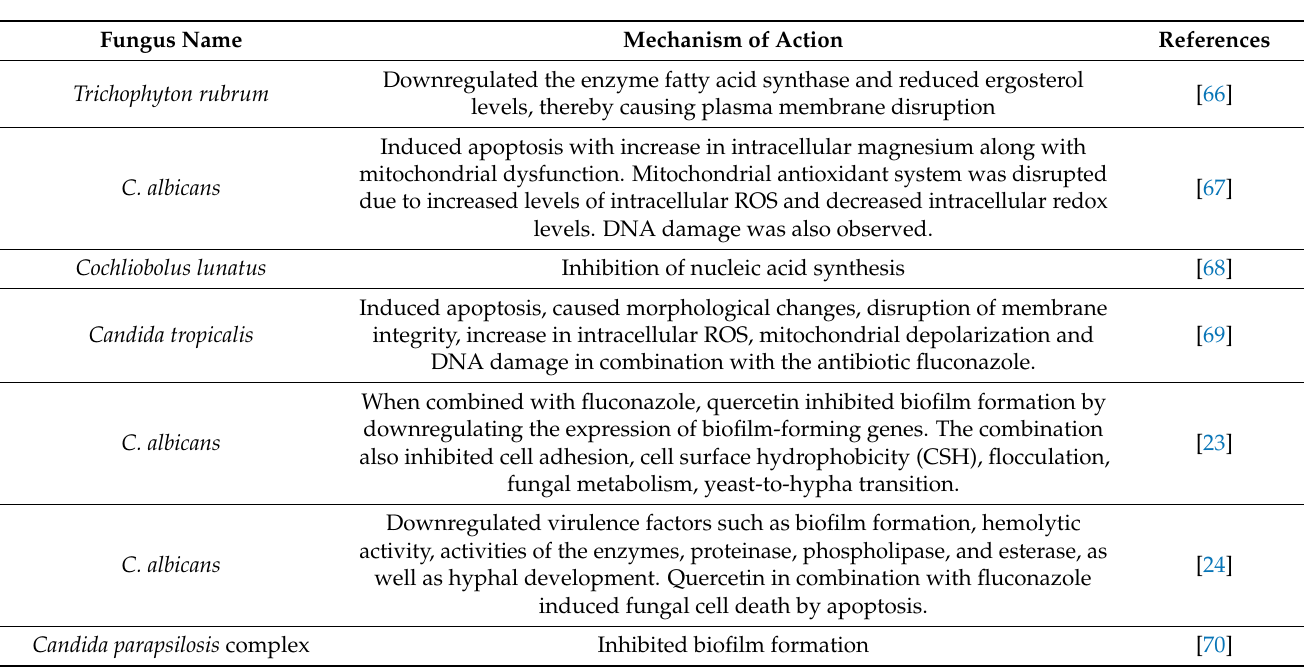
Table 1. Antifungal mechanism of